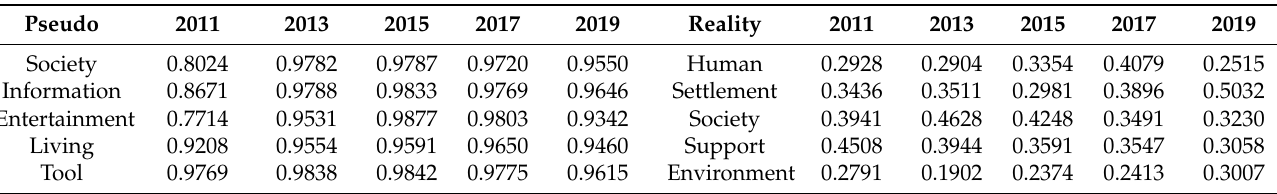
Table 3. The driving system of urban PHSs and RHSs in